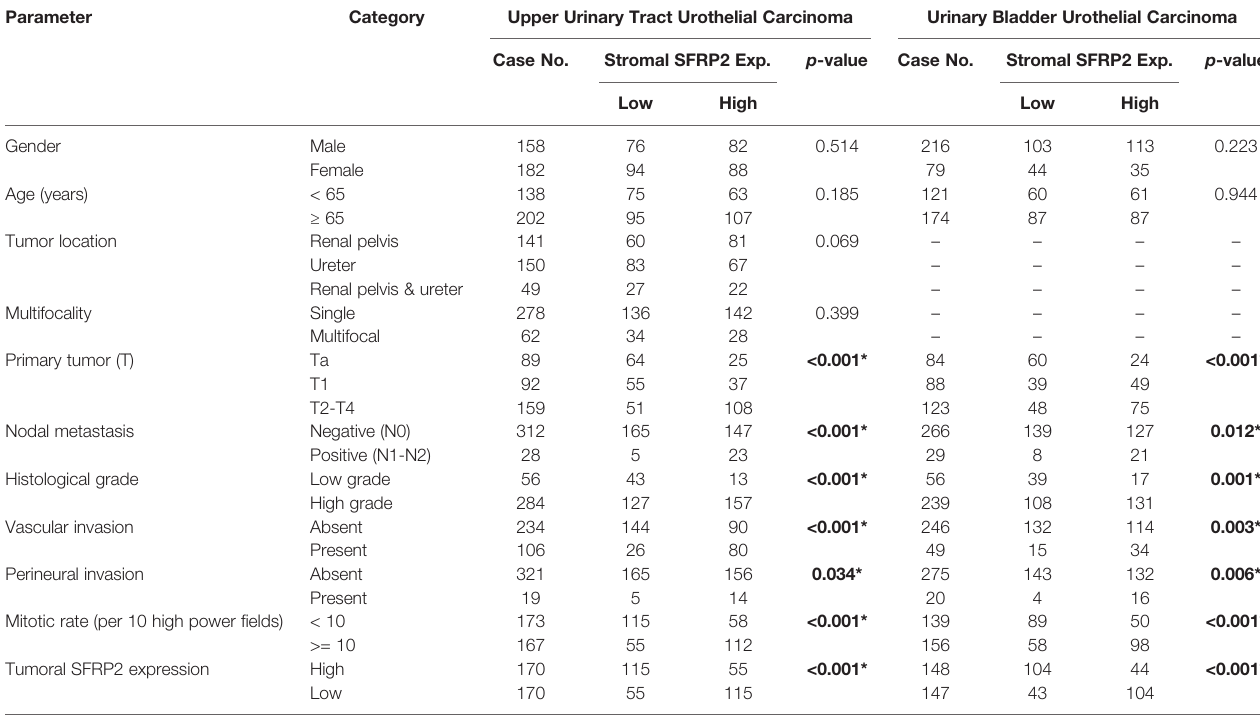
TABLE 2 | Correlations between stromal SFRP2 expression and other important clinicopathological parameters in urothelial carcinomas. Parameter